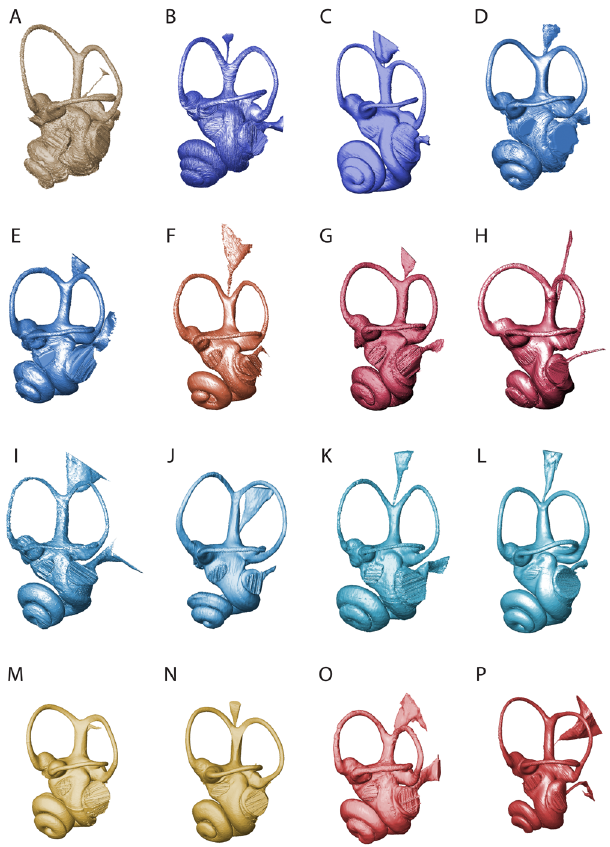
Fig. 4 | Bony labyrinth morphology of the different groups of ruminants. This includes the bony labyrinth of the oldest currently known genera of all the extant pecoran families, shown in ventrolateral view: Stem Ruminantia ( A Hypisodus minimus AMNH9354), Tragulidae ( B Dorcatherium crassum NMB San15053 and C Moschiola meminna NMB 2319), Stem Pecora ( D Prodremotherium elongatum MNHN.Qu4596 and E Parablastomeryx primus AMNH13822), Dromo- merycidae ( F Dromomeryx scotti AMNH FAM33800), Antilocapridae ( G Cosoryx furcatus AMNH FAM32426 and H Antilocapra americana NMB C.1618),